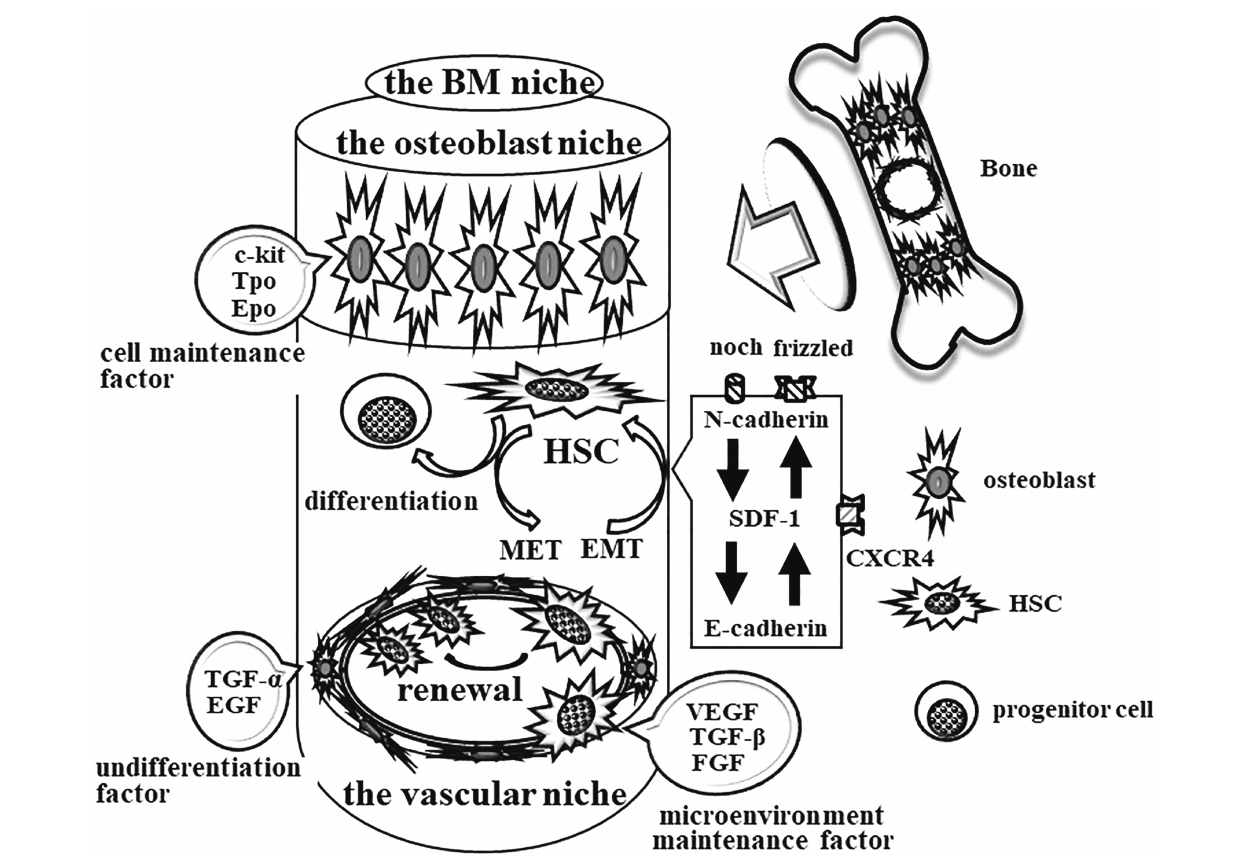
FIGURE 1 | Schematic image of the maintenance system for HSCs in bone marrow (BM). The mature BM maintains the vascular niche at least by vascular endothelial growth factor (VEGF), tumor growth factor beta (TGF β ), and fibroblast growth factor (FGF). Conversely, TGF- α and epithelial growth factor (EGF) keep the nature of HSCs. E-cadherin participates in the HSC-vascular niche interaction to maintain renewal and multipotency and block differentiation in HSCs. In addition, the mature BM also maintains the osteoblast niche by c-Kit ligand, Tpo, and Epo for the maintenance of HSCs and progenitors. SDF-1/CXCL12 attracts HSCs and progenitor cells via CXCR4 between the vascular niche and the osteoblast niche. N-cadherin participates in the interaction of HSCs with thrombopoietin-producing osteoblasts to regulate